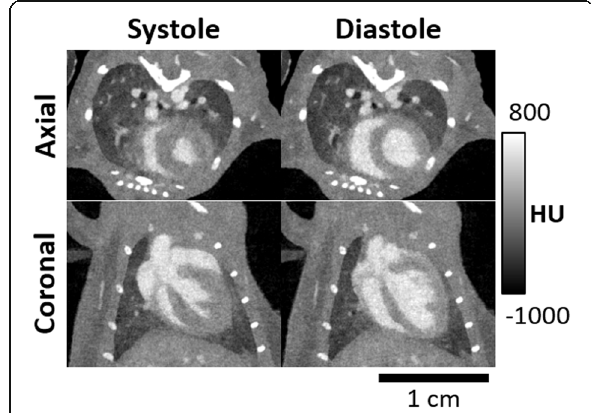
Fig. 3 Axial and coronal views of systole and end-diastole in a mouse model with intravascular iodine contrast. Projection data were sampled using a prospective gating scheme. These images represent two of the ten cardiac acquired phases, i.e. , diastole and systole. Reconstruction was performed using a four-dimensional iterative technique based on the split Bregman method [16]. Figure courtesy of Dr. Cristian T. Badea, PhD, Duke